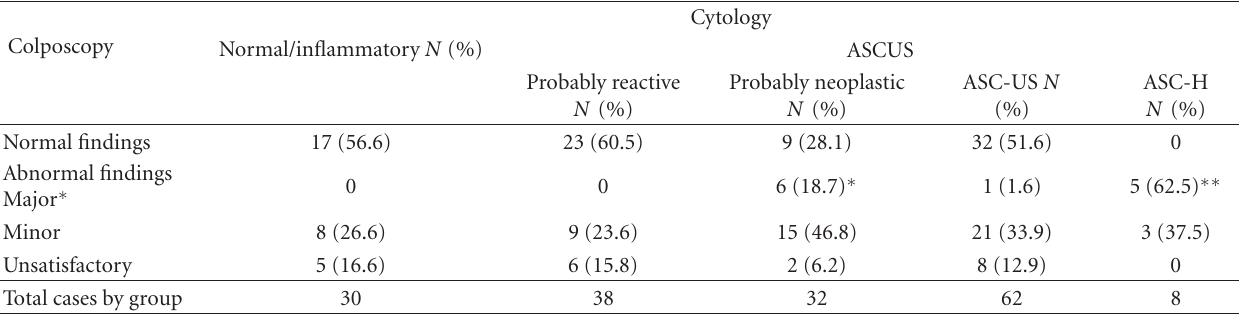
Table 2: Principal colposcopic findings in patients with an initial diagnosis of ASCUS who, upon review, were reclassified as normal/inflam- matory cytology, probably reactive ASCUS, probably neoplastic ASCUS, ASC-US, and